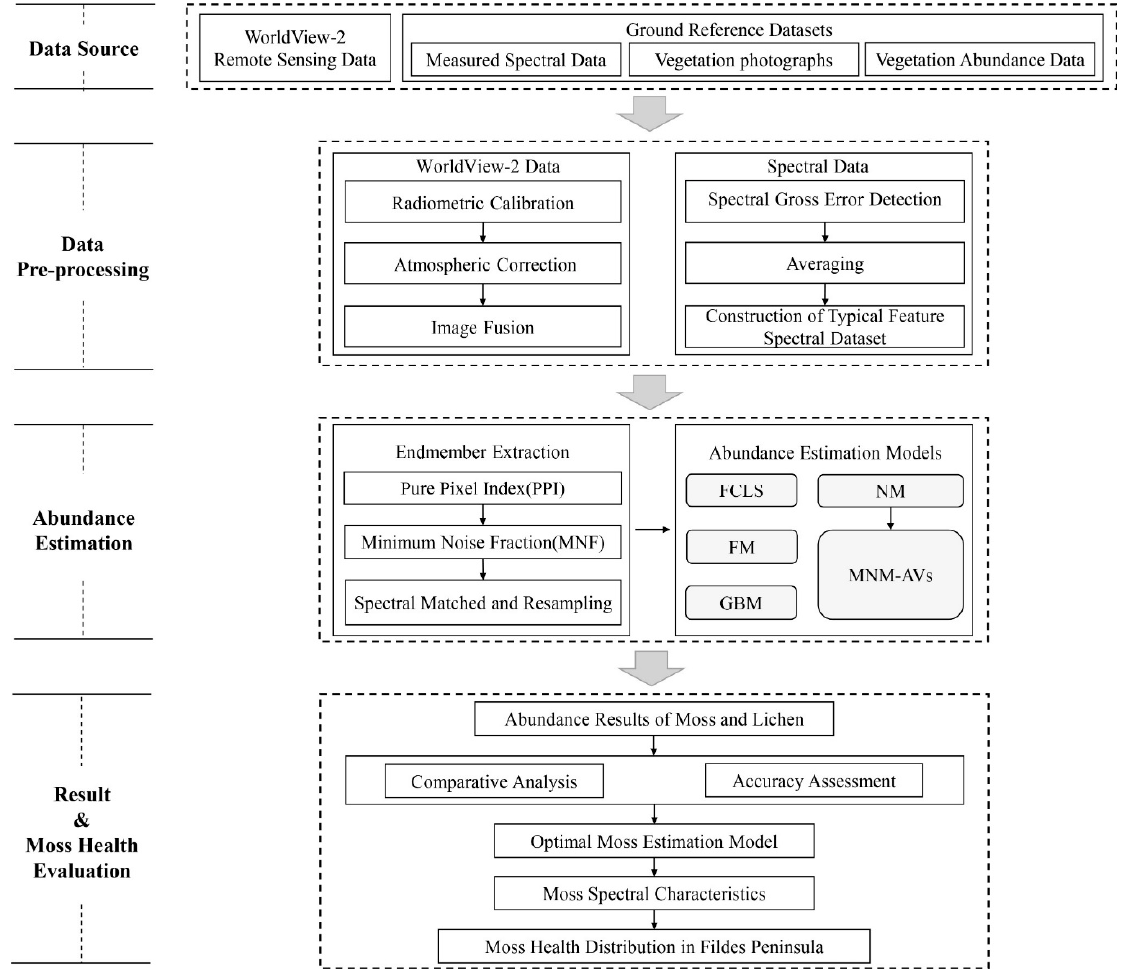
Figure 3. The overall workflow of the study.